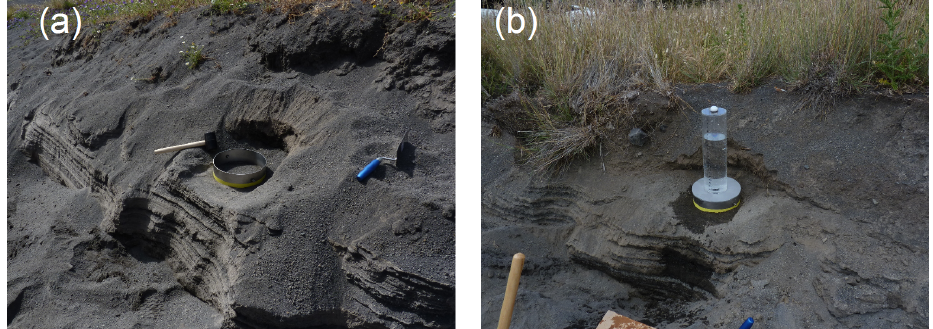
Figure A3. (a) Ring infiltrometer: 6cm is buried in the 1888–1890 tephra fallout deposit. (b) Ring infiltrometer during the infiltration measurements showing the bottle turned upside down with water infiltrating the